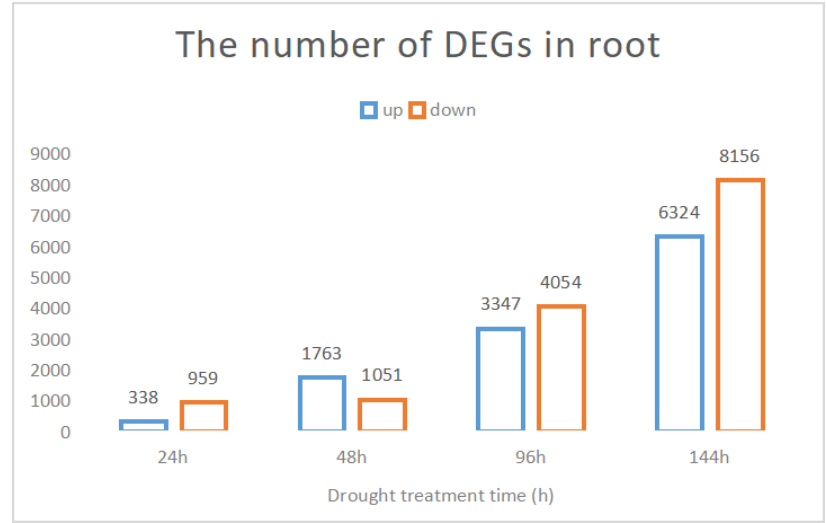
Figure 1. The number of DEGs under four time points in the roots of pearl millet after drought stress. The blue bars represent the number of upregulated genes, and the orange bars represent the number of downregulated genes. DEGs, differentially expressed genes.